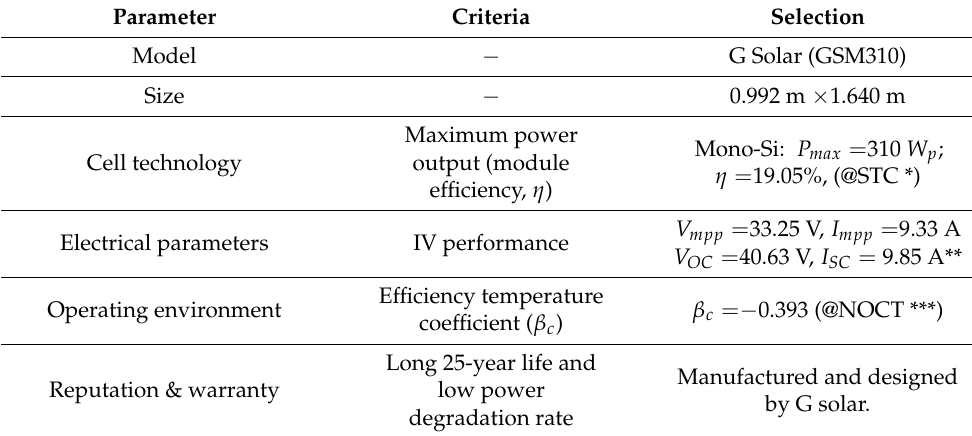
Table 10. PV module specifications [53].